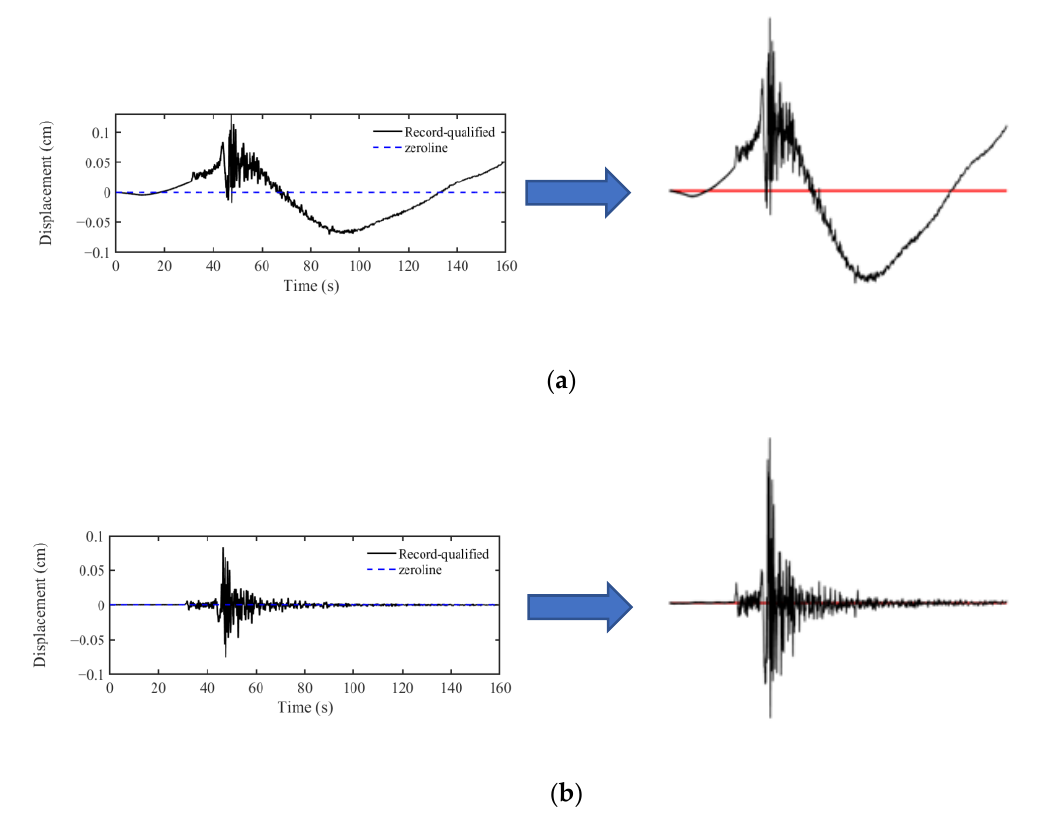
Figure 4. The processing of displacement diagram. ( a ) Unqualified displacement time series curve; ( b ) qualified displacement time series curve.